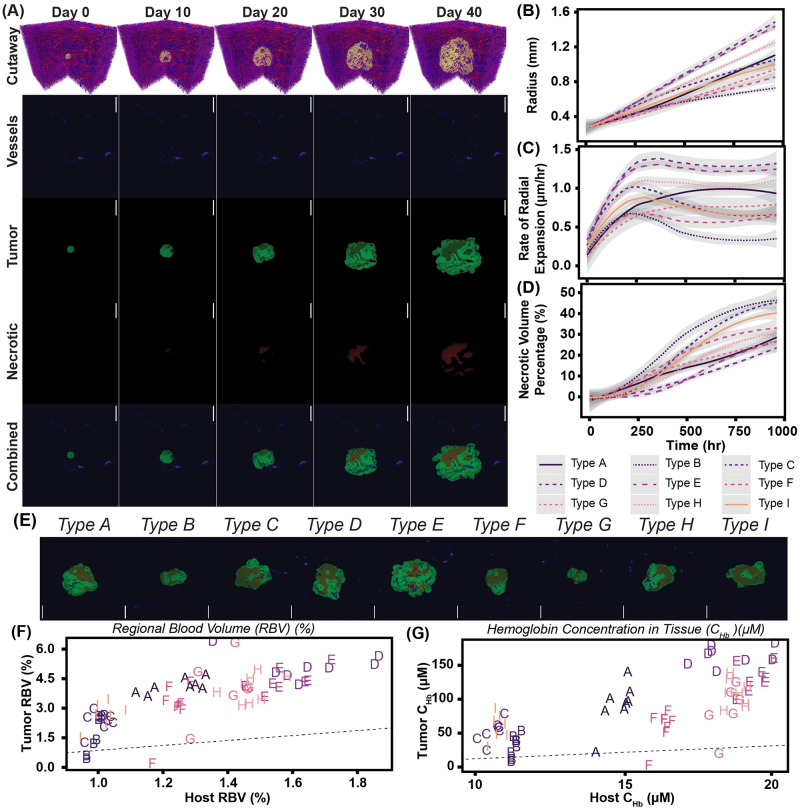
Artificial mouse tumor growth and resulting biophysical properties after 40 days of growth.(A) Visualization of cutaways, vessel (blue), tumor (green) and necrotic (red) volume fraction cross sections for artificial mouse tumor growth over 40 days. The tumor shown here was grown in a type A vascular bed. Also shown in this figure are the (B) radius, (C) rate of radial expansion, and (D) necrotic volume percentages for each vessel bed type (Type A-I). Shaded areas in these plots represent a 95% confidence interval across each type of vessel bed configuration. (E) Visualization of combined volume fraction cross sections for selected tumors from each of the vessel bed types (Type A-I). Comparison of (F) RBV and (G) CHb,tis between the tumor and host tissue in the artificial tumor constructs. The letter labels indicate the vessel configuration. The dashed line separates the tumor properties greater than and less than the host properties. For all tumor cross sections the scale bar is 1 mm.